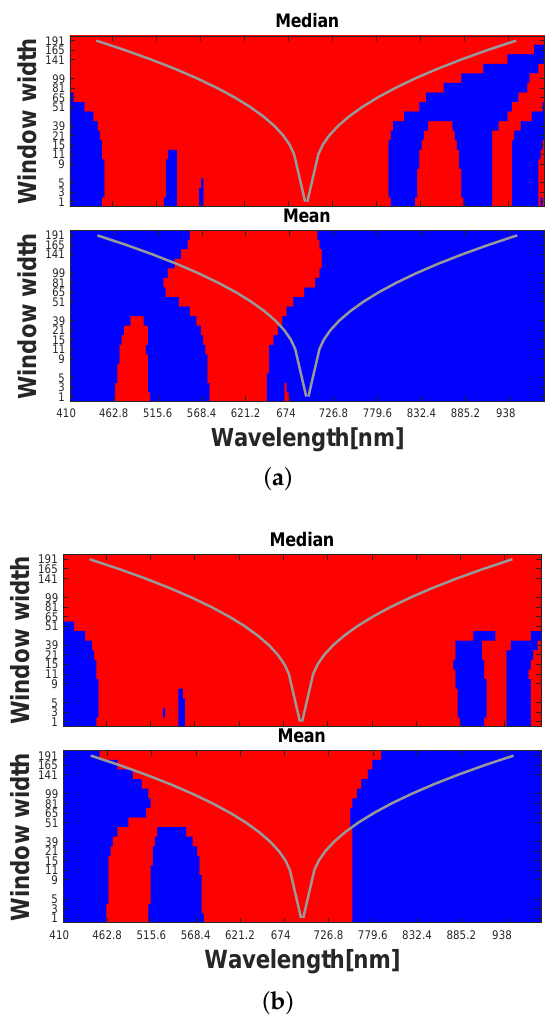
Figure 7. ( a ) Significance map for the comparison of the day 0 frozen fish acquisitions with day 4 acquisition number two using the median and the mean. ( b ) Significance map for the comparison of the day 0 frozen fish acquisitions with day 4 acquisition number four using the median and the mean.The Hannig-Marron rejection threshold was used in all maps.